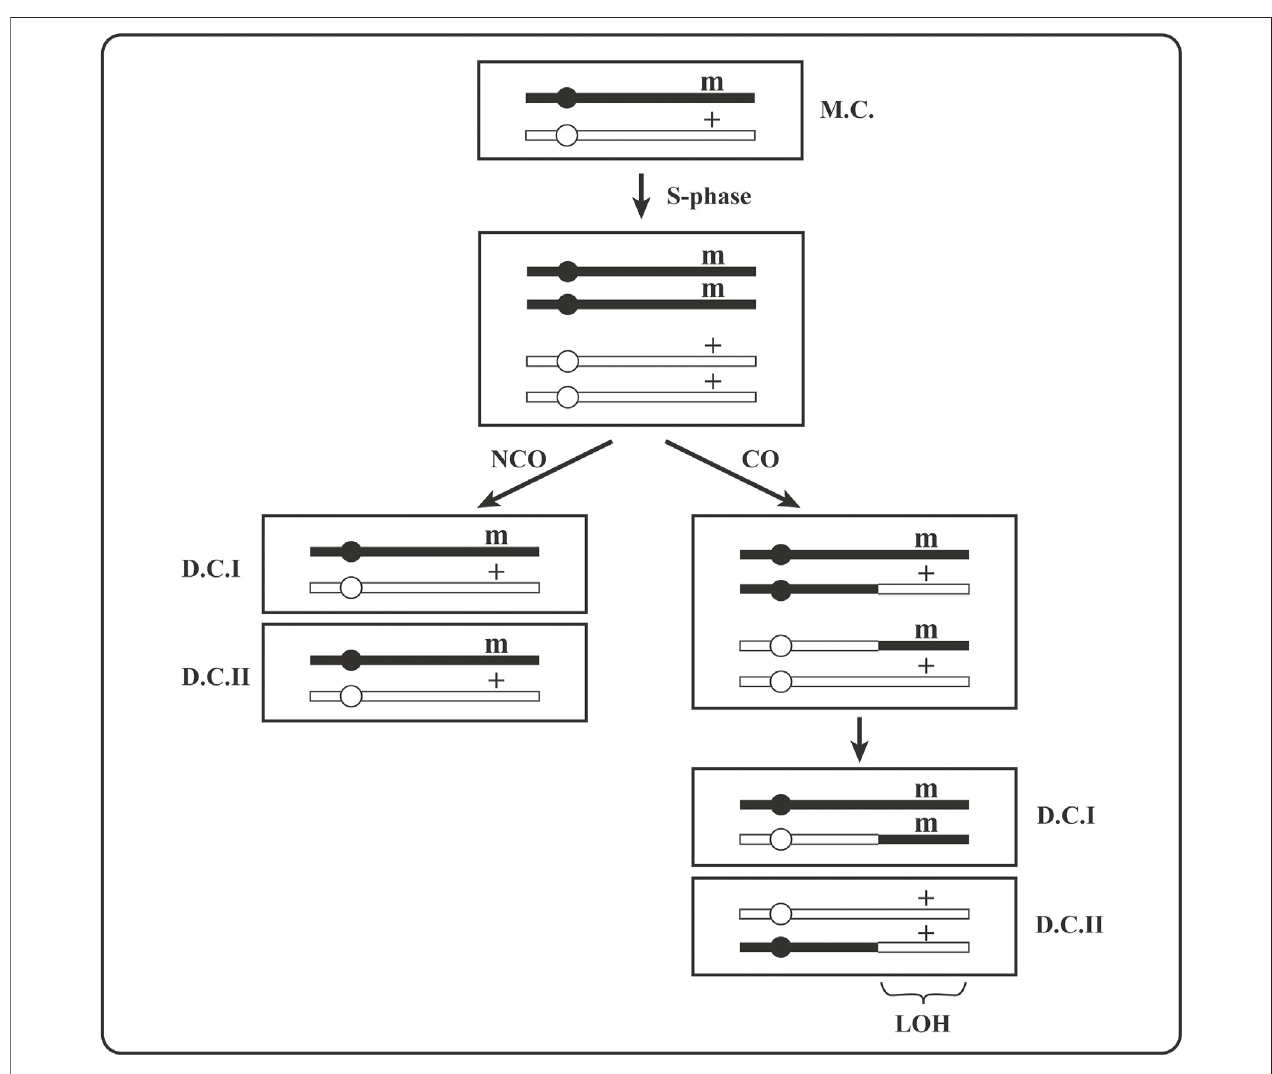
FIGURE3| Adrawingofthe expression ofarecessiveheterozygousmutationbyits segregation tohomozygosity via mitotic recombination inmother cell. (+) isan activegene, (m) isitsinactivemutantversion; MC isaheterozygous(+/m)mothercelland DC areheterozygous(+/m)orhomozygous(+/+andm/m)daughtercells; CO standsforcrossoverand NCO fornon-crossover.Geneconversionthatcancreate+/+orm/mhomozygosityisnotshown. LOH islossofheterozygosityforallparental (maternal or paternal) markers (SNPs) extending from the crossover site to the end of the chromosome.